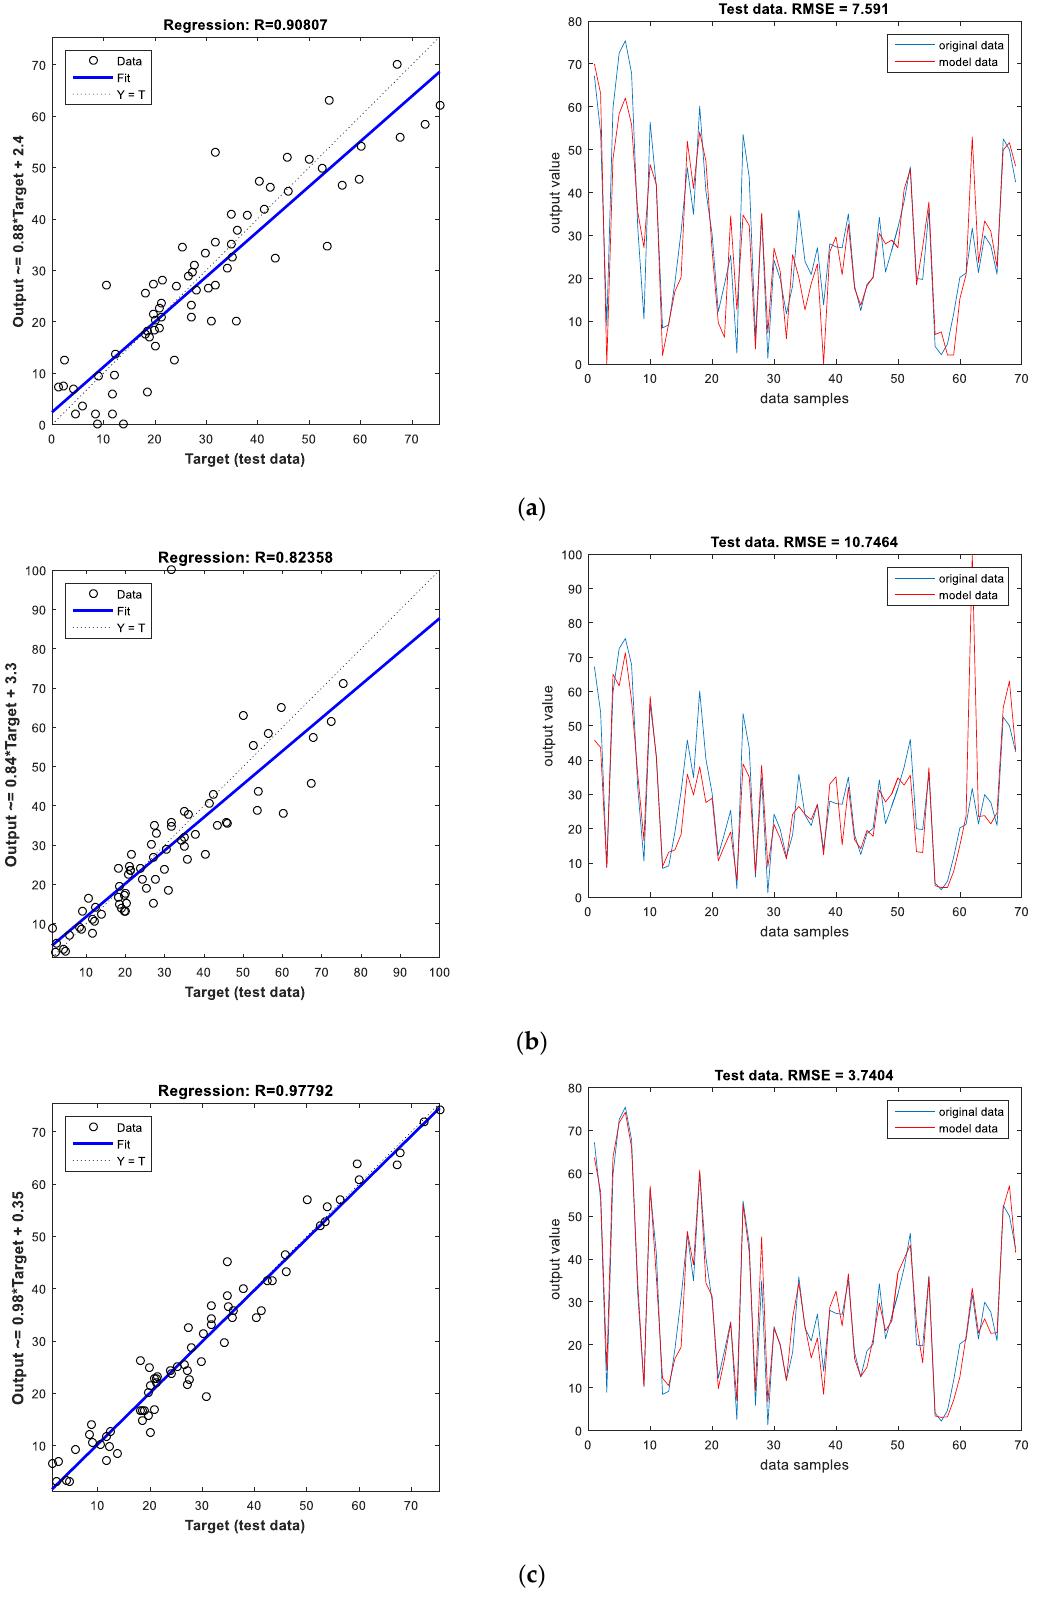
Figure 8. Performance evaluation using the test dataset for ANN models with ( a ) one hidden layer and ten neurons in the hidden layer, ( b ) two hidden layers having seven and two neurons respectively, ( c ) three hidden layers having nine, three and two neurons respectively.